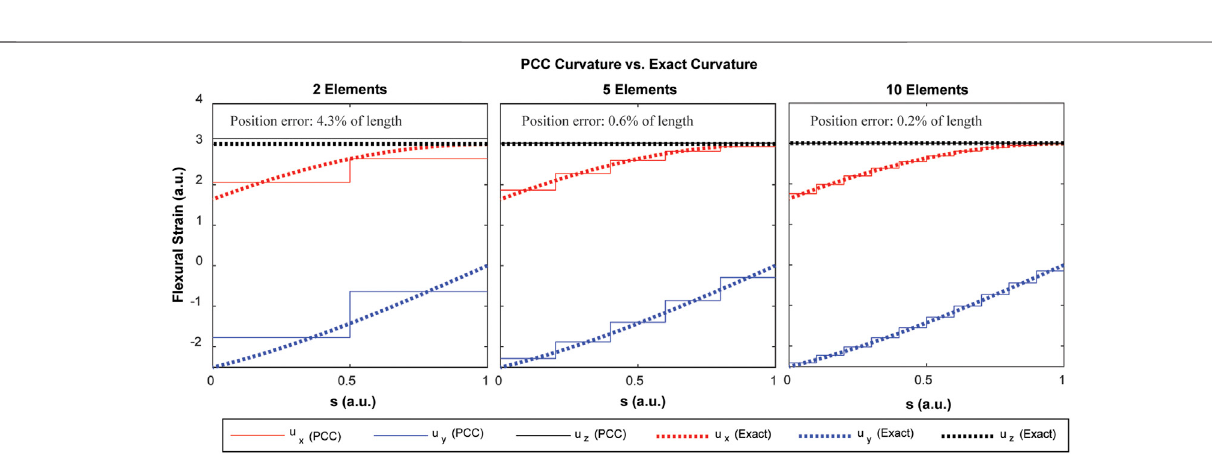
Frontiers in Robotics and AI |